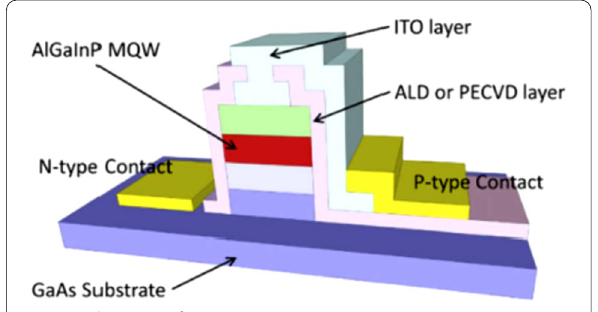
Fig. 2 Schematic of a μ‑LED